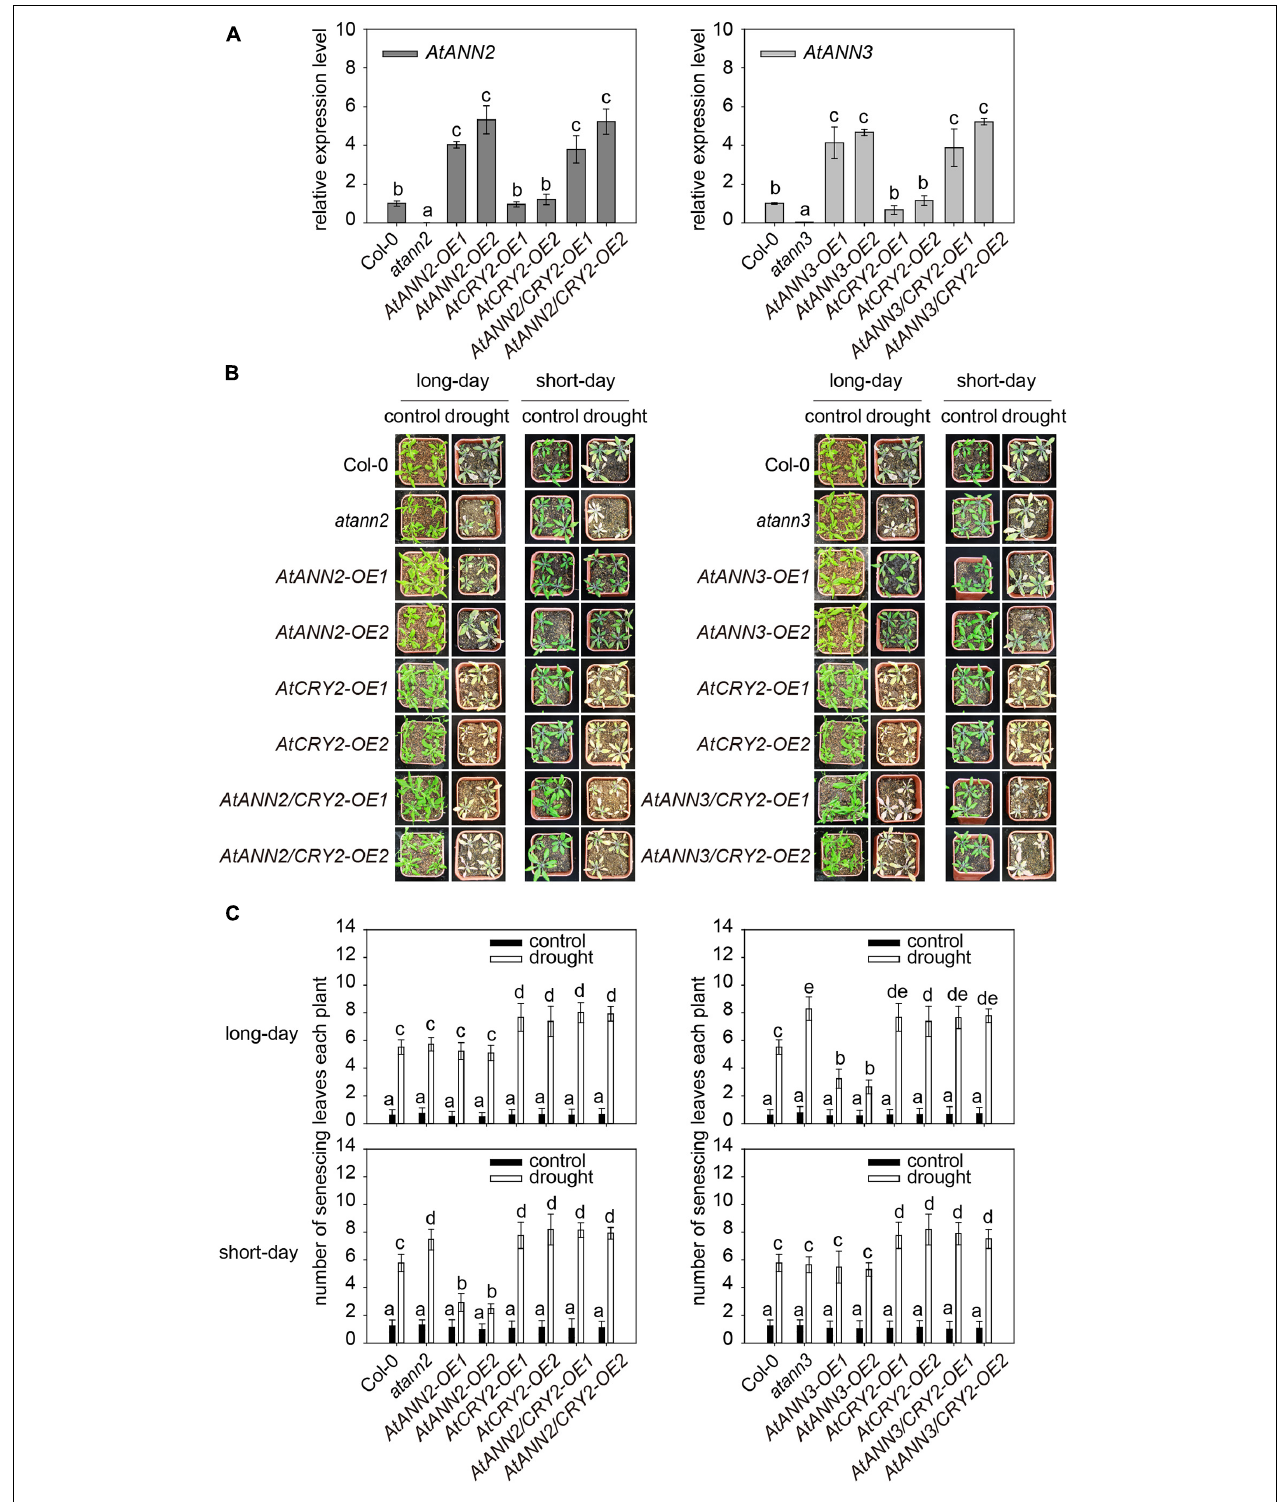
FIGURE 7 | Function of AtCRY2 in the photoperiodic regulation of AtANN2 and AtANN3 in response to drought stress. (A) Relative expression of AtANN2 and AtANN3 genes in the AtCRY2-OE background ( AtANN2 / CRY2-OE and AtANN3/CRY2-OE ) and those in the Col-0 background ( AtANN2 - OE and AtANN3-OE ). (B) Plant growth phenotype (senescing leaves) of the AtCRY2 -related lines the same as Figure 7A in response to drought stress under long- or short-day conditions. (C) Statistical analysis of senescing leaves of genotypes in Figure 7B . Different letters indicate significant differences with each treatment at P <0.05 level.